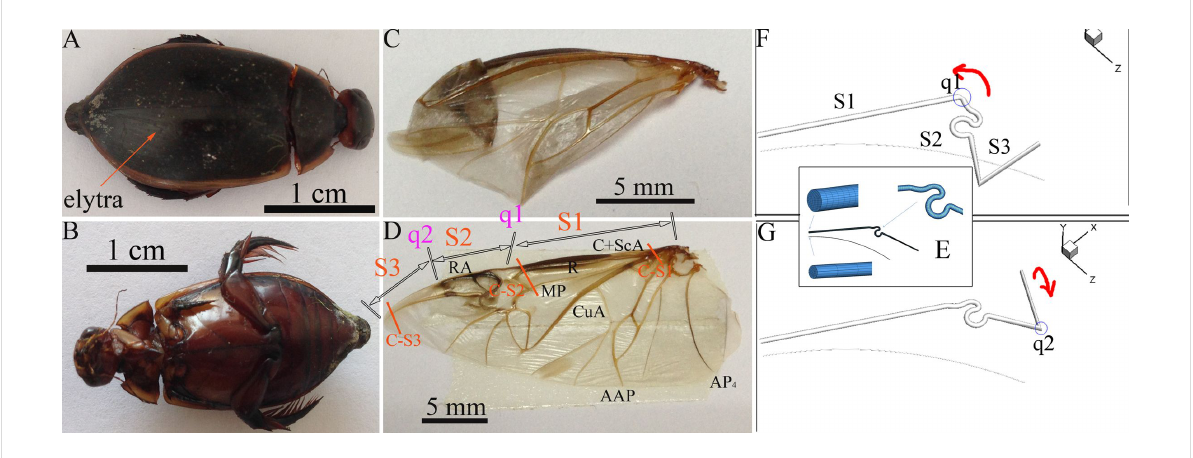
Figure 1: (A) and (B) C. japonicus , excised hind wings in folded state (C) and unfolded state (D), where C is costa, ScA is subcosta anterior, RA is radius anterior, R is radius, MP is media posterior, CuA is cubitus anterior, AAP is anal anterior posterior, and AP 4 is anal posterior. (E–G) The local mesh figure and the vein movement diagram. The costa vein was set as three segments: S1 is fixed, S2 is connected to S1 and can rotate, and S3 is connected to S2 and can rotate. S1 simulates C+ScA, while S2 and S3 simulate RA, which is the folded vein. q1 and q2 are rotating points. C-S1 to C-S3 are the cutting positions of the cross sections of the wing base, the posterior part of the wing, and the folded zone in C for Figure 3.